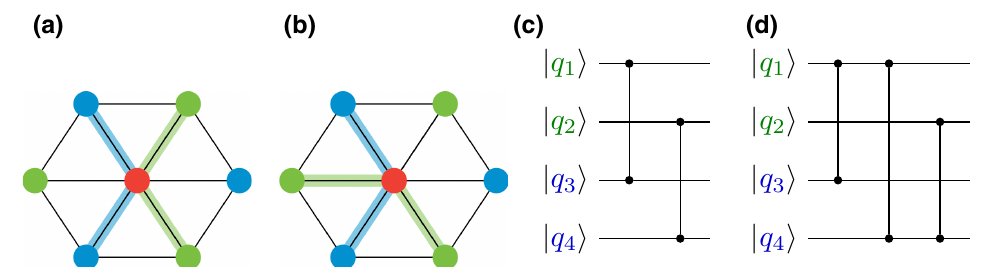
FIG. 11. Logical gates implemented by (cid:5) R 2 (v) in a [[6,4,2]] code. (a) One choice of logical Pauli basis, where for each highlighted edge e we have a logical operator X ( e ) with the labeling (clockwise from the top left) X 3 , X 1 , X 2 , and X 4 . Here, two subsets of logical operators have corresponding edges the join of which is a triangle. (b) A different choice of logical Pauli basis, where clockwise from the top left we have X 3 , X 2 , X 4 , and X 1 . Here, three subsets of logical operators have corresponding edges the join of which is a triangle. (c),(d) The logical operator implemented by (cid:5) R 2 (v) for (a) and (b), respectively.